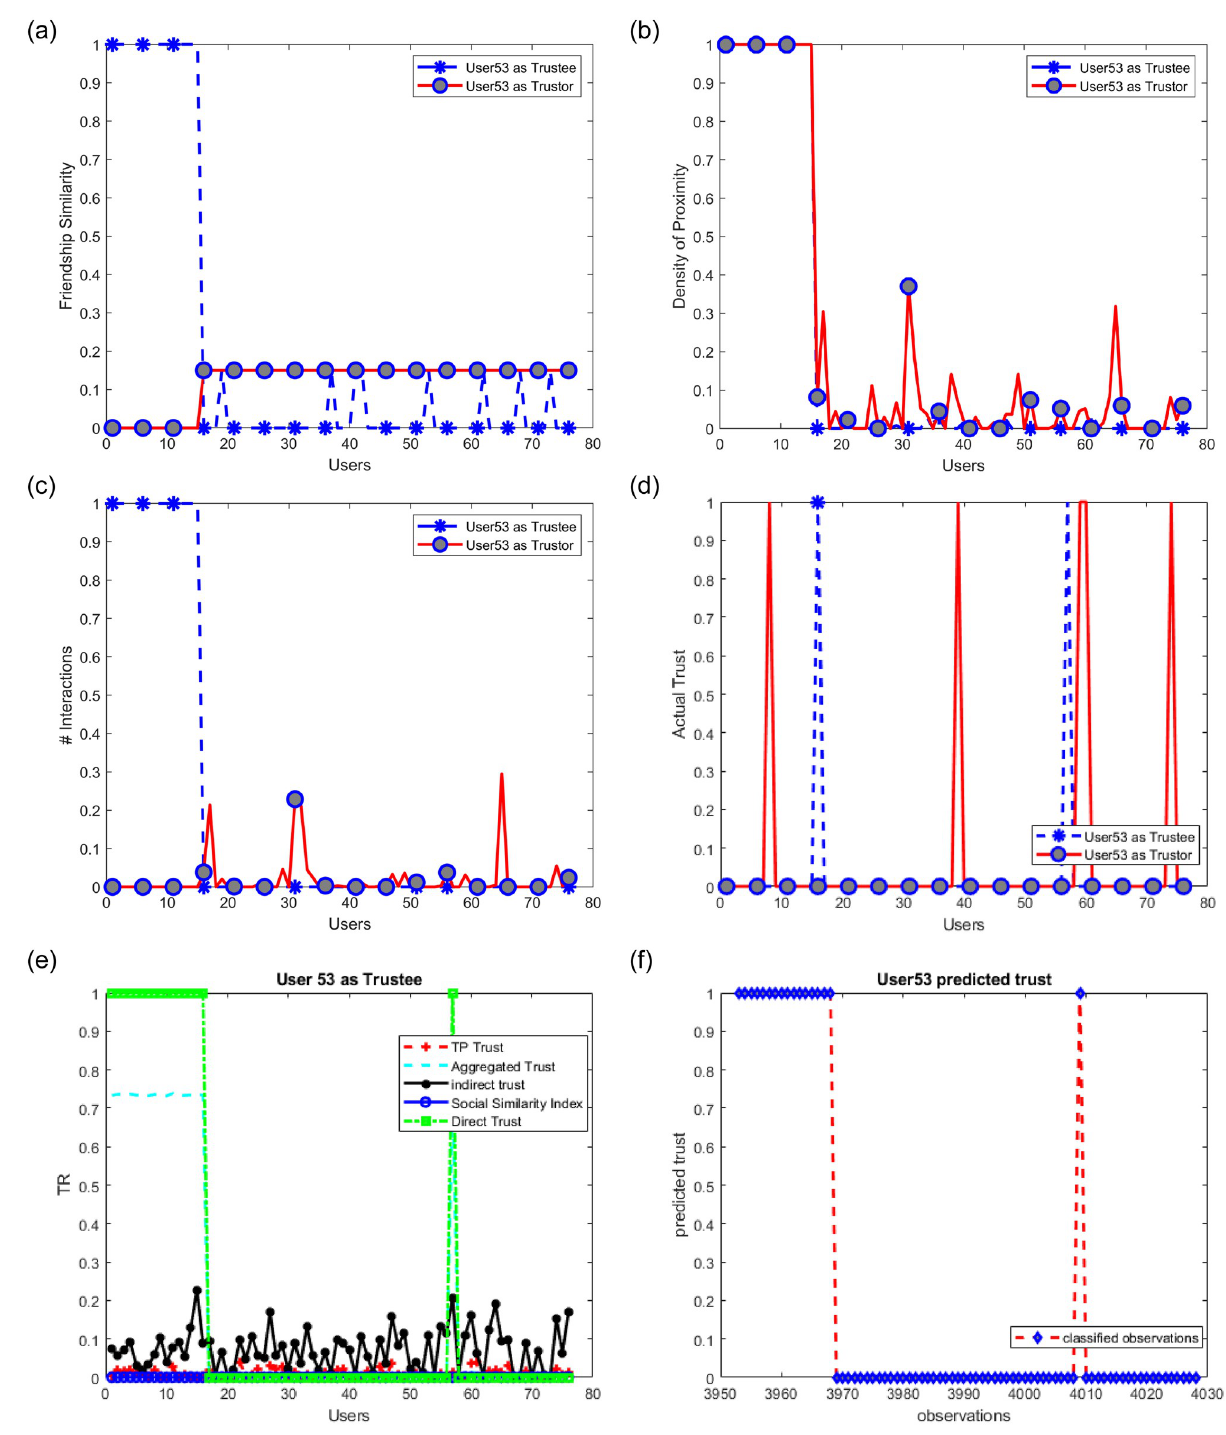
Fig 15. Malicious users give positive ratings to user53 (Fxy, PrZz, Prox, Cc, tr).